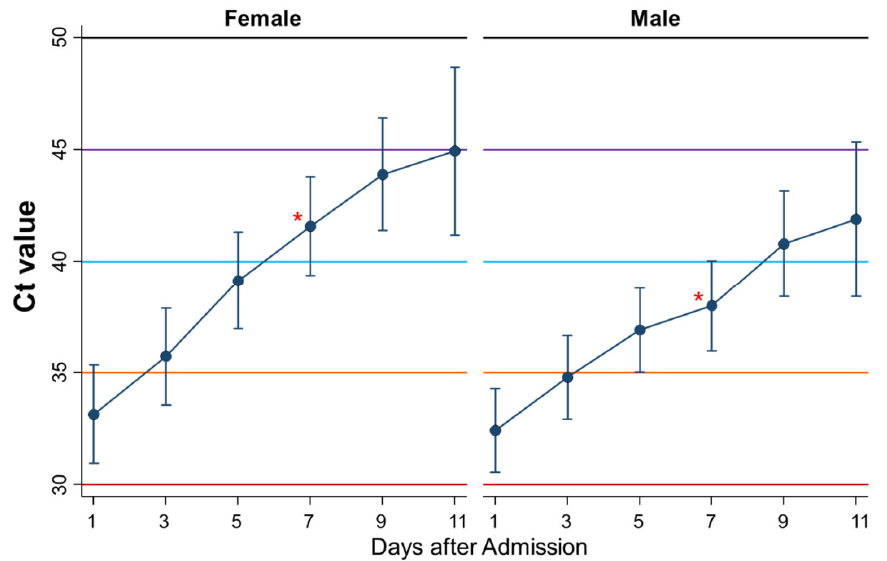
Figure 11. Differential kinetics of Ct values between female and male patients. Mean Ct with 95% confidence intervals. When the Ct value is 40 or more, the PCR test result is considered negative. * represents a significant difference ( p < 0.05).